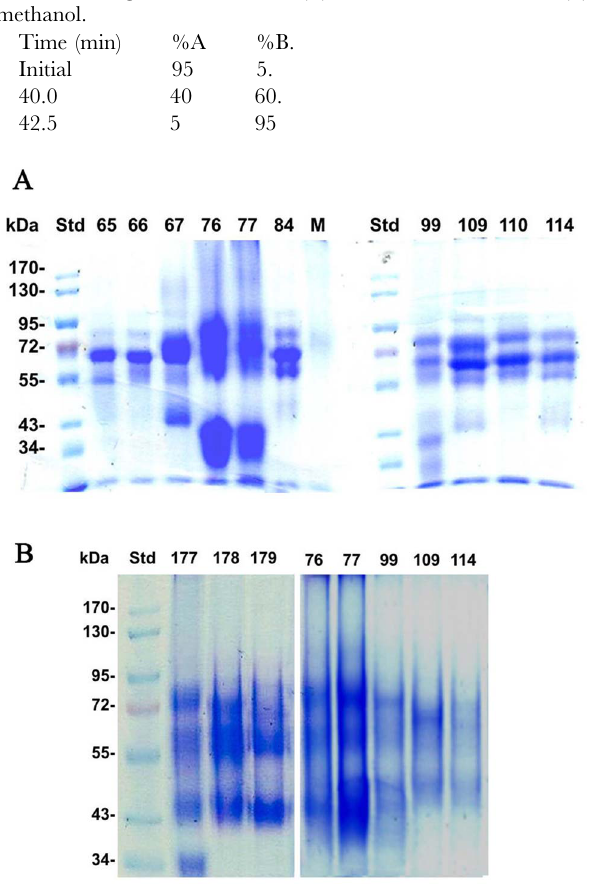
Figure 3. Changes in protein profiles and electrophoretic mobility of proteins induced by 3- month storage of honeys at room temperature. ( A ) fresh honeys; ( B ) stored honeys.